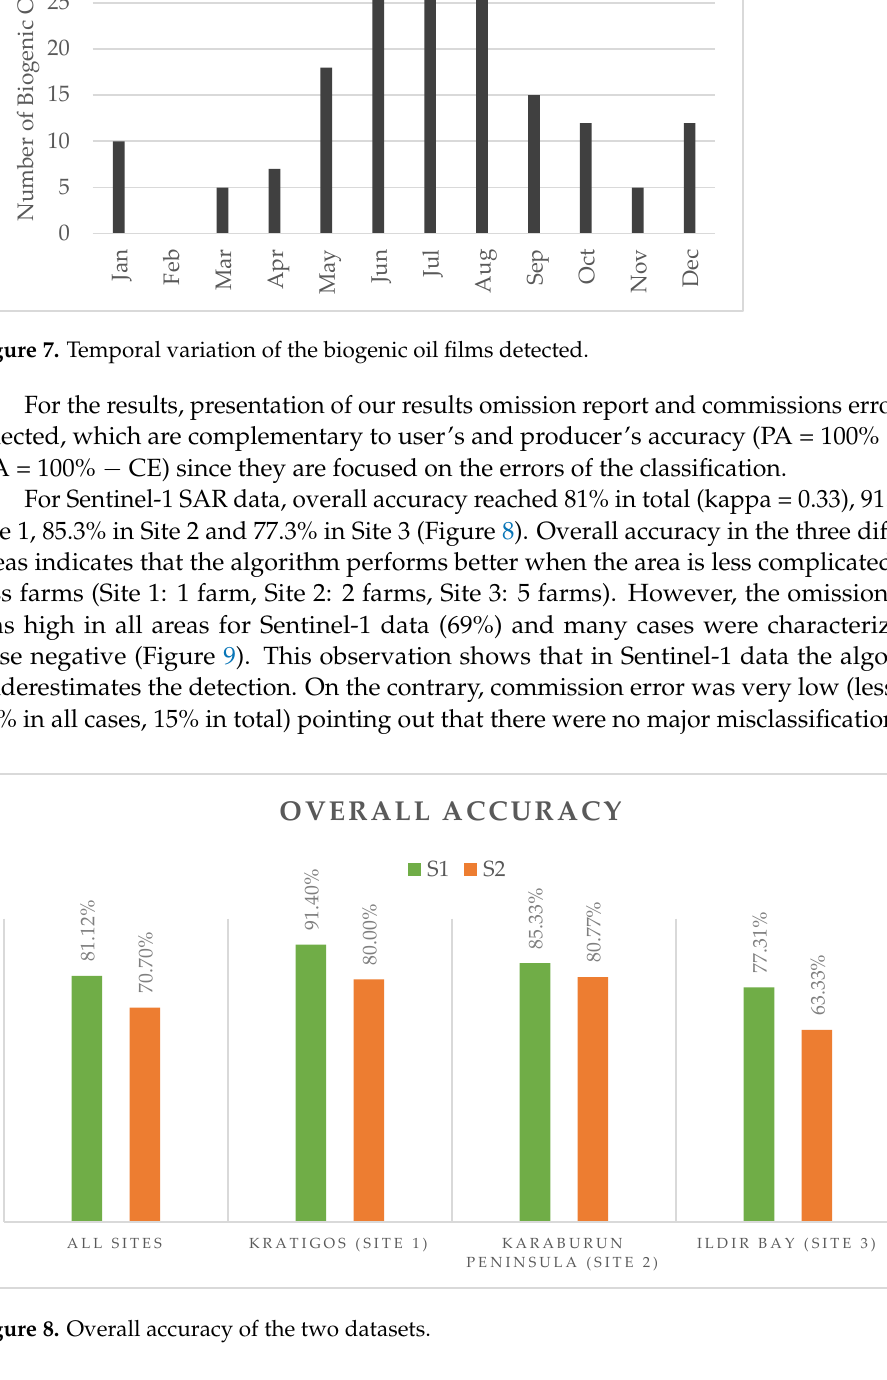
265 Figure 9. Omission and commission errors in all sites for the two datasets.